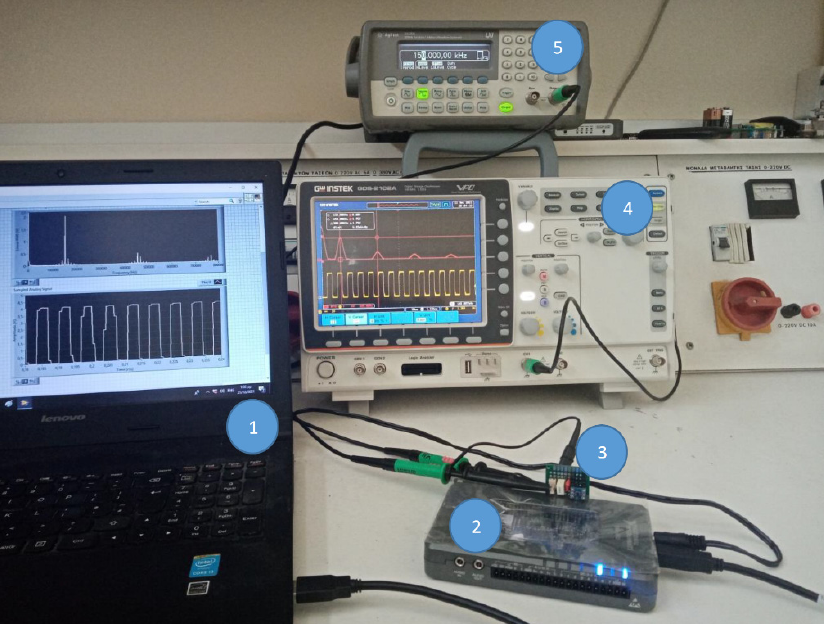
Figure 15. Experimental setup for the tested system. ( 1 ) PC screen; ( 2 ) MyRio device; ( 3 ) Custom ADC card; ( 4 ) Oscilloscope; ( 5 ) Pulse generator.